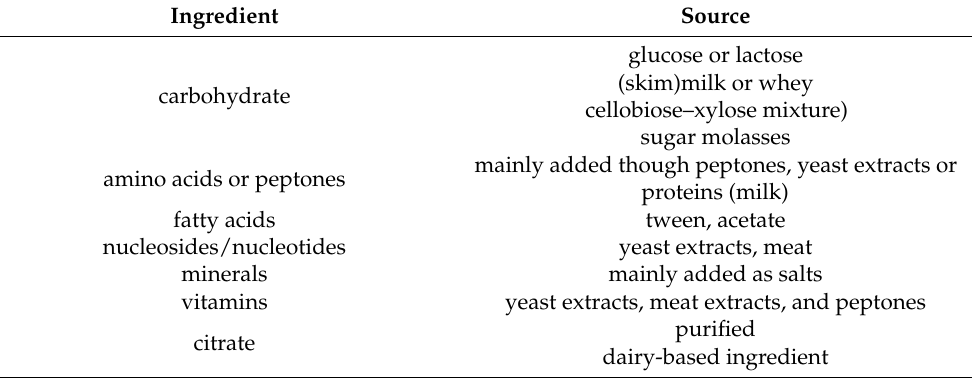
Table 1. Ingredients used in industrial growth media [94–97].